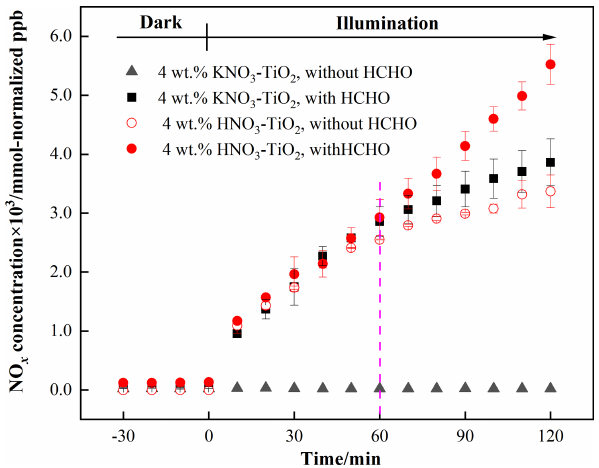
Figure 2. Effect of formaldehyde on the renoxification processes of different nitrate-doped particles at 293K and 0.8% of relative hu- midity; 365nm LED lamps were used during the illumination ex- periment. The initial concentration of HCHO was about